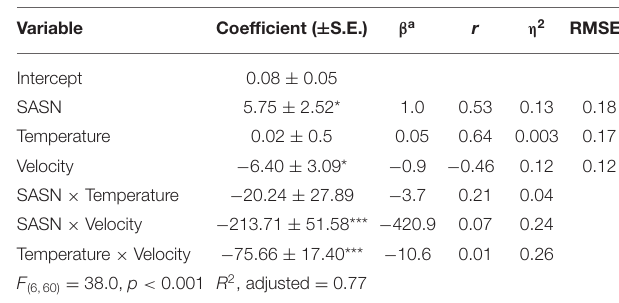
TABLE 4 | Regression of daily movement distances ( ◦ latitude) predicted by maintaining constant SASN, constant daily maximum temperature (20 ◦ C),